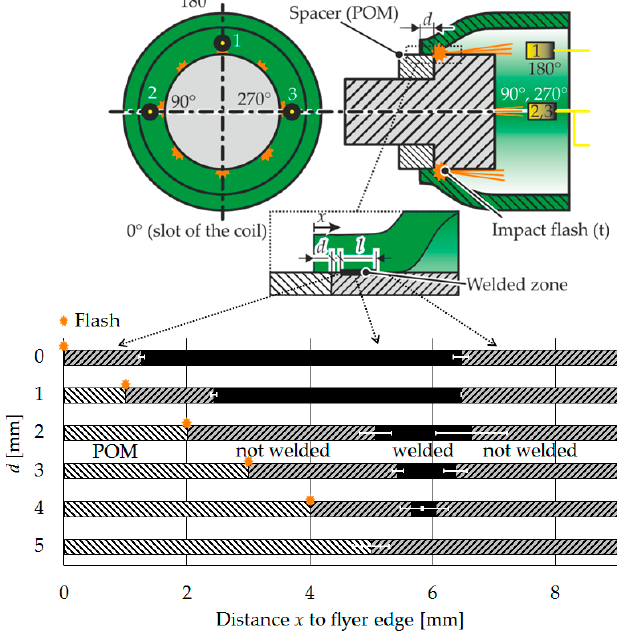
Figure 10. Mean values of welding start and end at 90°, 180°, and 270° for varied values d.